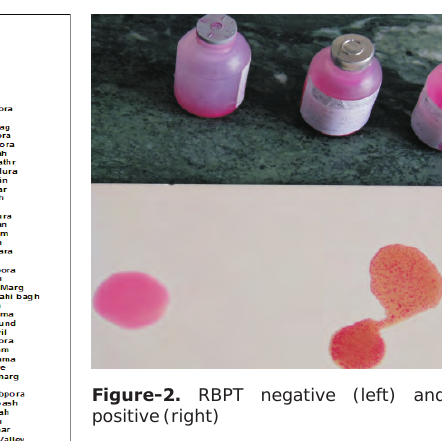
Figure-2. RBPT negative (left) and positive